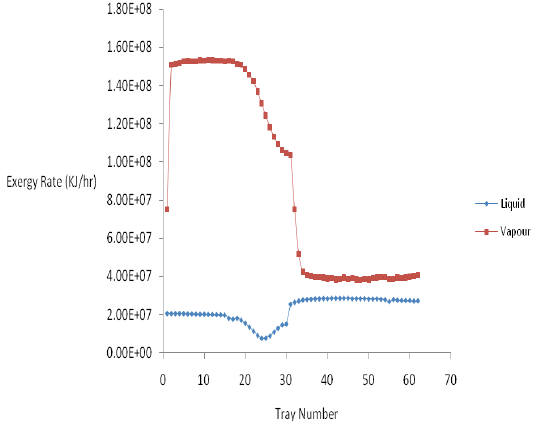
Figure 18. Profile of exergy rate versus tray number for Debutanizer of base case, 80 o C, Reflux Ratio 2